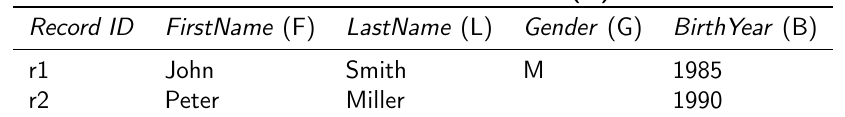
| = 3. The top table e